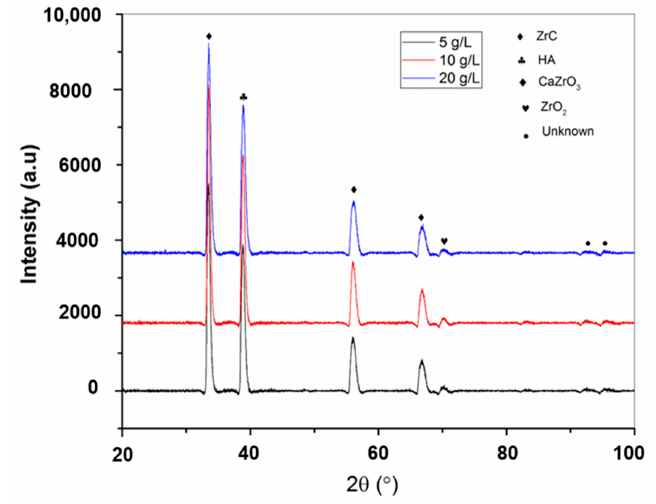
Figure 6. X-ray powder Diffraction (XRD) pattern of the coated Zr 67 Cu 11 Ni 10 Ti 9 Be 3 BMG processed at different HA concentrations indicating various oxides and carbide deposited on the BMG surface.